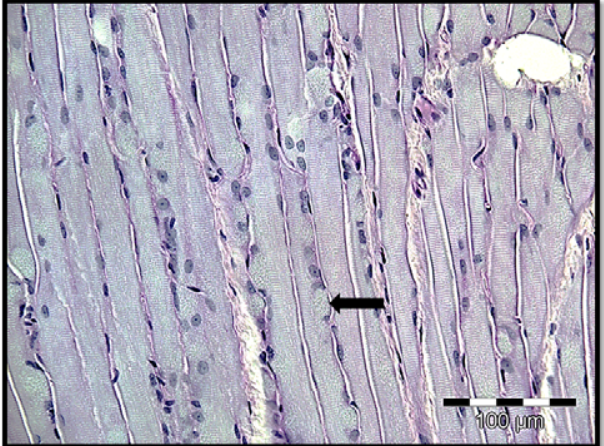
Figure 6b: Biopsied left m . triceps brachii biopsy stained with periodic acid-Schiff (PAS) showing uniform muscle atrophy and pale staining, with multifocal pale non-staining subsarcolammal areas (arrow) where the nemaline rods are aggregated causing the membrane to bulge outwards. Light microscopy, magnification x400.